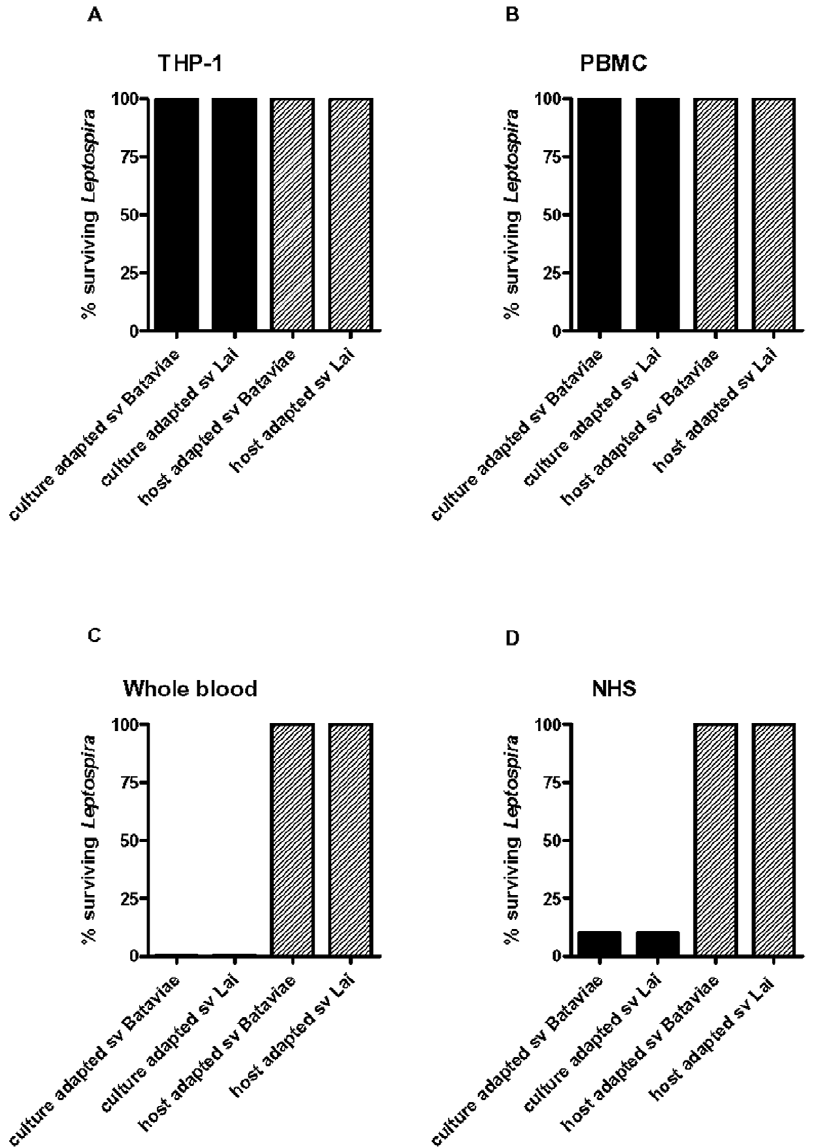
Figure 6. Killing of leptospires. Abbreviations: sv, serovar; NHS, normal human serum. Leptospires are incubated for 6 hours. 10-fold serial dilutions were made after 6 h in EMJH, and leptospiral growth was evaluated after 3 weeks incubation at 30 u C. Culture- and host-adapted serovar Bataviae, culture- and host-adapted serovar Lai were used under the following conditions: Panel A: THP-1 cells, panel B: PBMC, panel C: whole blood, panel D: NHS